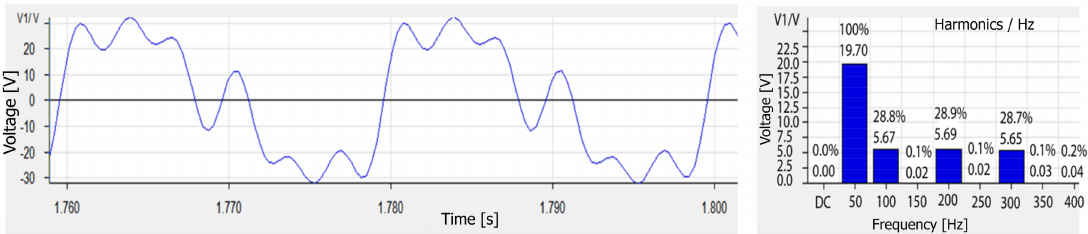
Figure 8. Decomposed voltage waveform with Fourier transform/Matlab window.